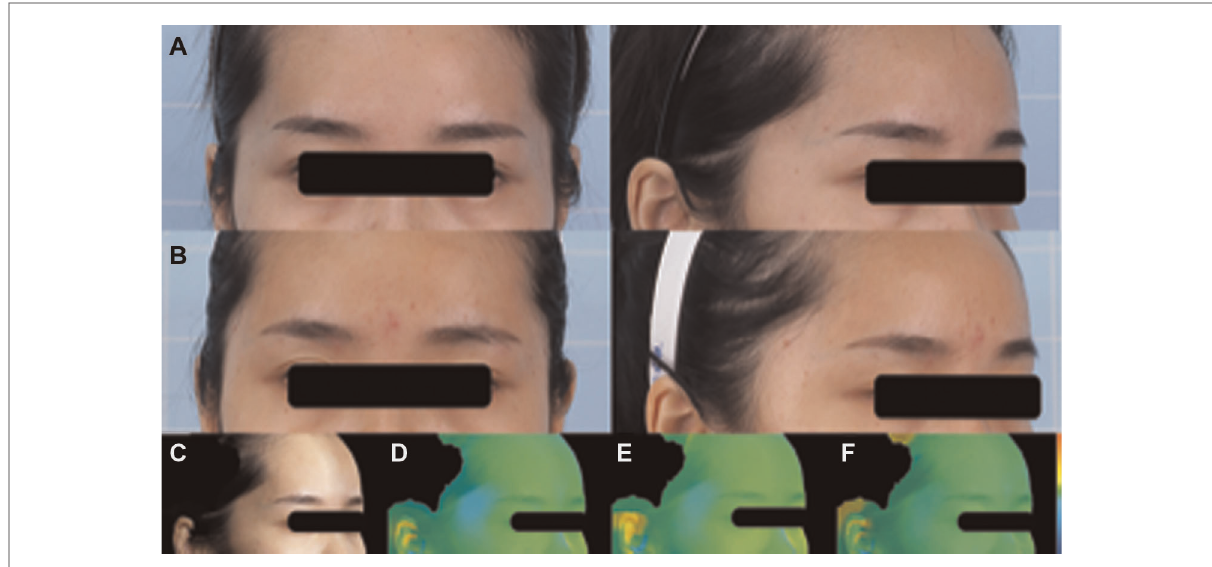
FIGURE 7 A 27-year-old female patient complained about temporal hollowness on both sides. SVF-gel (3.9 ml) was injected into the right temple, and 4.3 ml was injected into the left temple under one autologous fat grafting procedure. No temple hollowness was found at 12 months in either temple. ( A ) Preoperative front and right oblique photos. ( B ) Preoperative front and right oblique photos at 12 months. ( C ) Preoperative right oblique photo. ( D – F ) 3D reconstruction of right oblique images at 1, 6, and 12